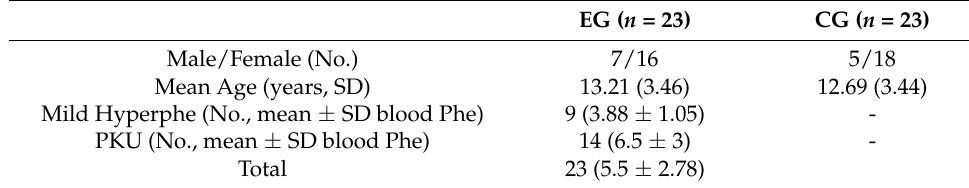
Table 1. Main features of the study